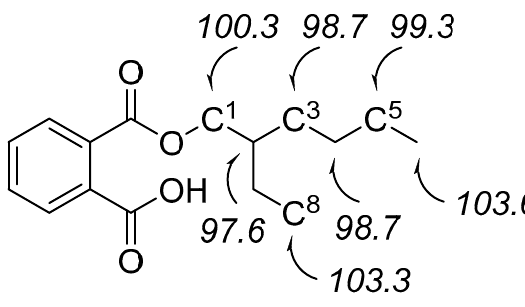
Figure 10. BDE CH values (in kcal·mol − 1 ) of aliphatic C–H positions of the phthalate substrate.